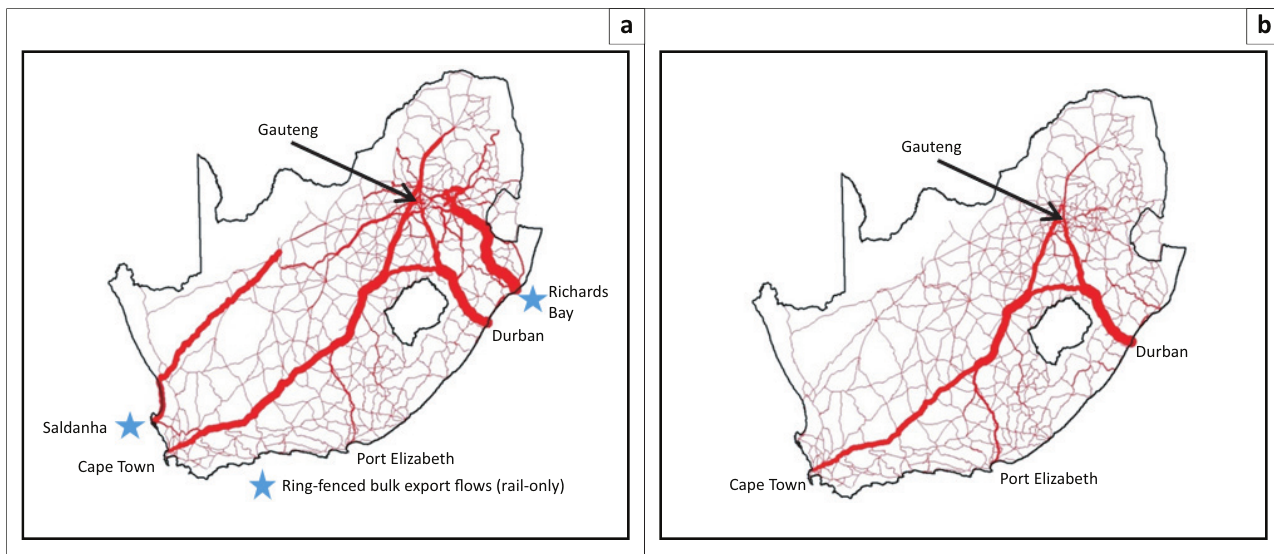
FIGURE 2: Geographical presentation of South Africa’s freight flow density – bulk export and general freight concentrations are distinct. Flow of (a) volume and (b) value for